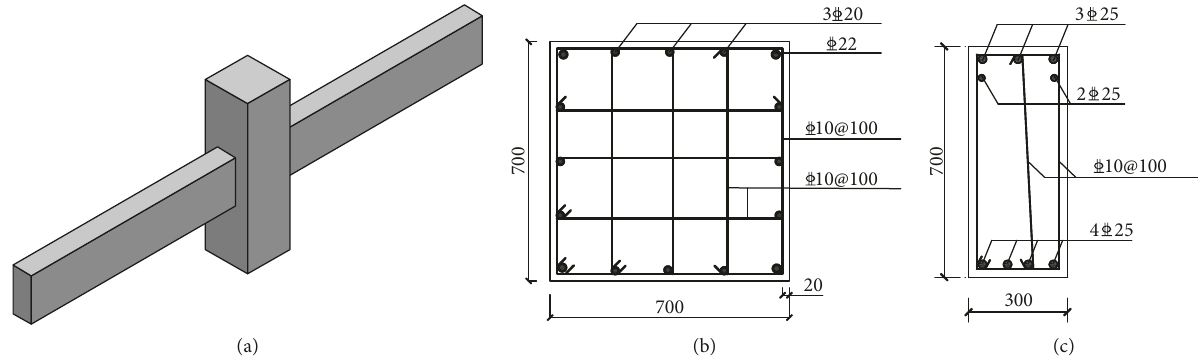
Figure 2: Sectional dimensions and reinforcement details of specimen XJJD: (a) schematic diagram, (b) column section, and (c) beam